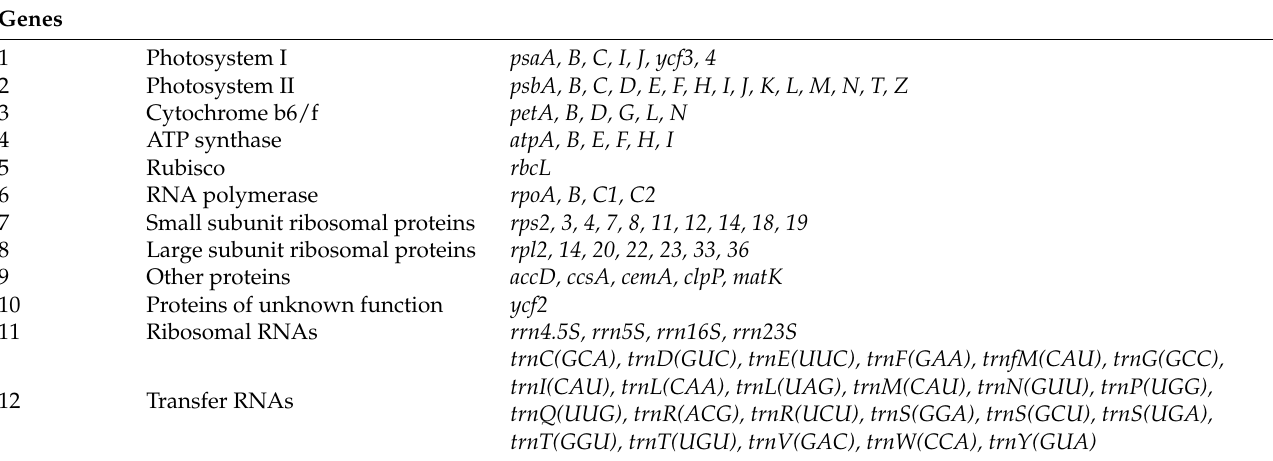
Table 2. List of genes in the T. nigrans and S. parasitica chloroplast